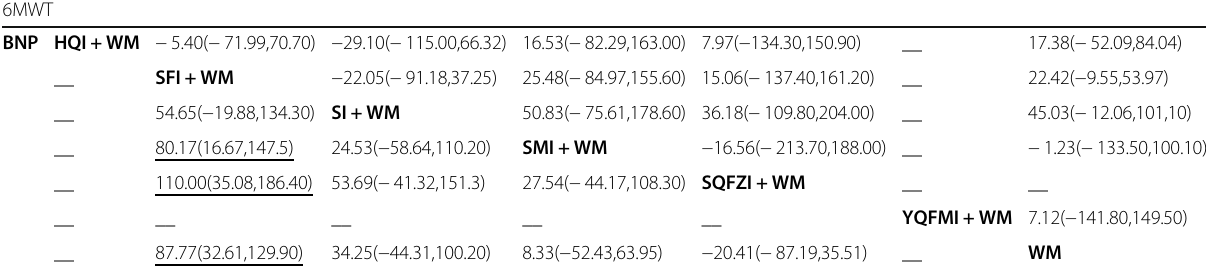
Table 3 Mean difference (95%CIs) of 6MWT (right upper part) and BNP (left lower part)